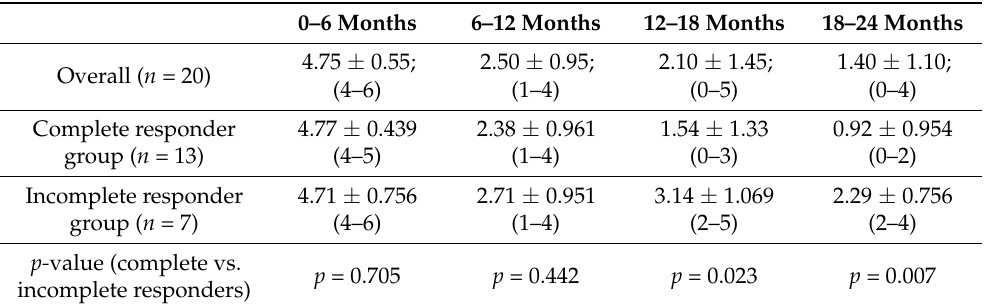
Table 2. Injections of ranibizumab per semester, expressed as average number of injections ± standard deviation; (minimum-maximum).